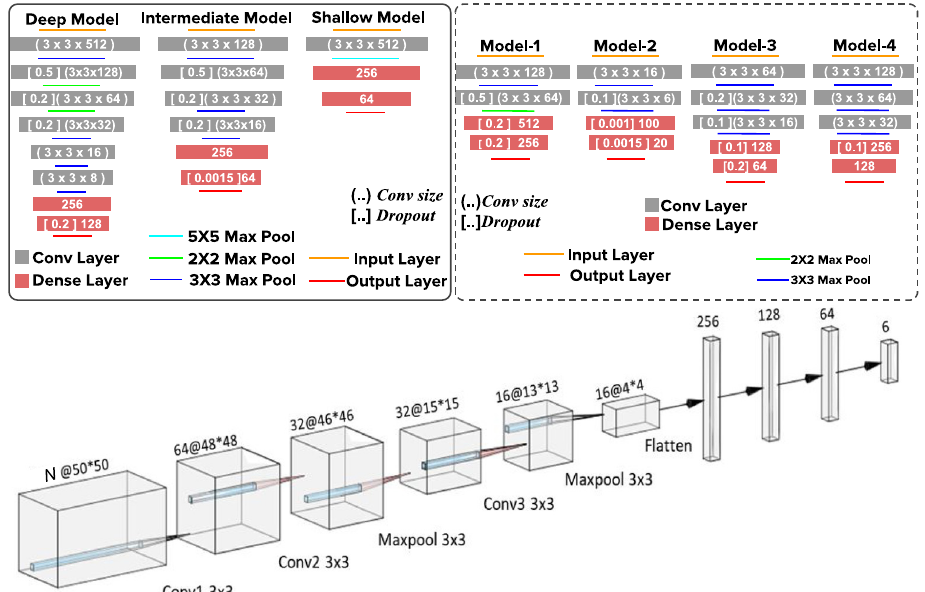
Figure 4. The CNN Architectures with varying depth. The models in the solid box are for the optimization of the model with varying depth. The models inside the dotted box are for the optimization of the parameters. Here, the orange line is the input layer and the rectangle represents the 2D convolution layer. The kernel size and number of kernels are indicated inside the round brackets, the dropout rate in square brackets, and the number of neurons in fully connected layers are placed directly within the rectangle. The aqua blue, green, and purple lines are the max-pool layers. The red line is the output layer and uses a SoftMax activation function. The final optimized architecture is as represented by the last 3D figure.